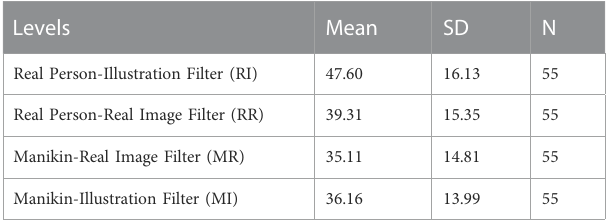
TABLE 1 Descriptive Statistics for initial changes. Lower mean indicates noticing initial changes sooner.